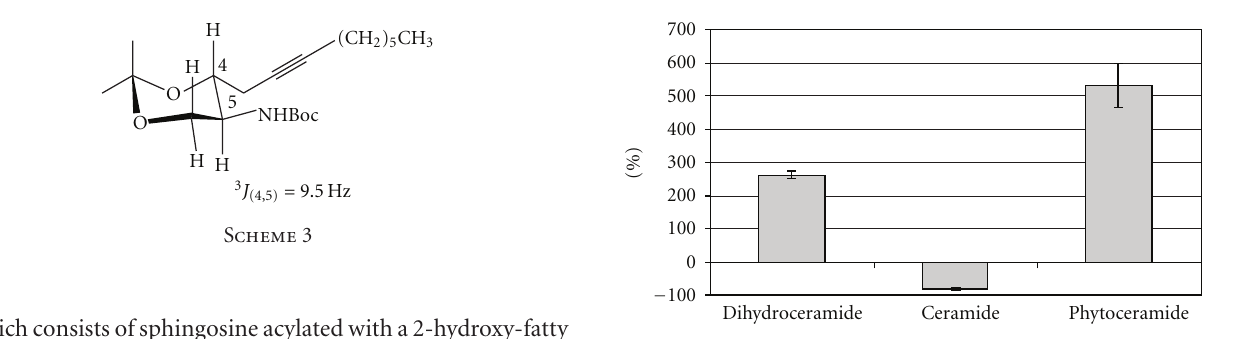
Figure 1: Incorporation of l -[3- 14 C]serine into ceramides of dif- ferentiated keratinocytes in the presence of 50 μ M of 1 . Deviations [%] from levels obtained in untreated cells, which were cultured as previously described [29], are